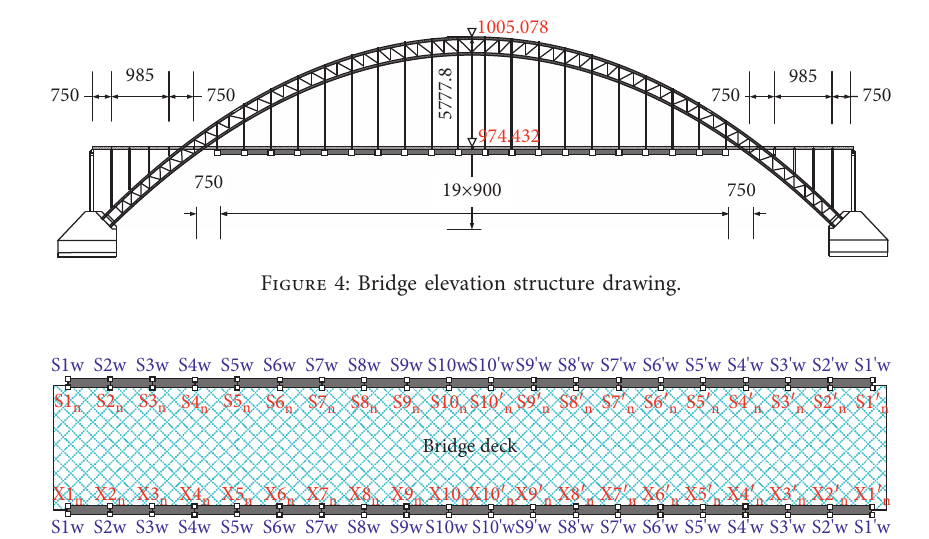
Figure 5: Schematic of arch bridge